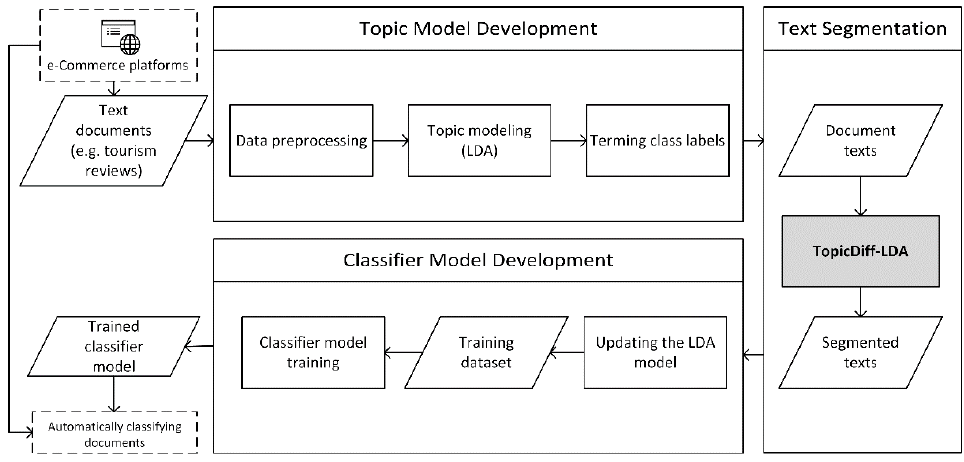
Figure 1. An overview of the proposed approach.